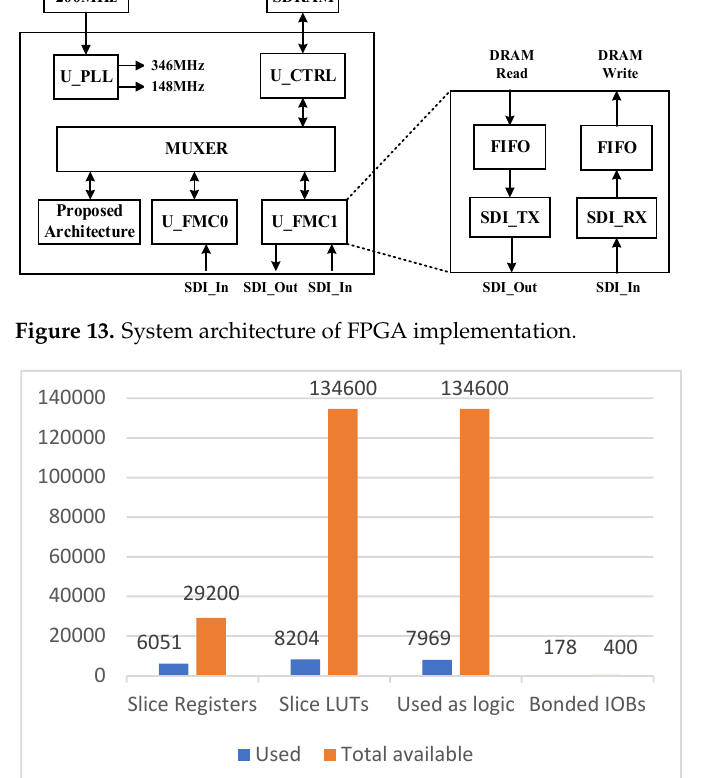
Figure 13. System architecture of FPGA implementation.